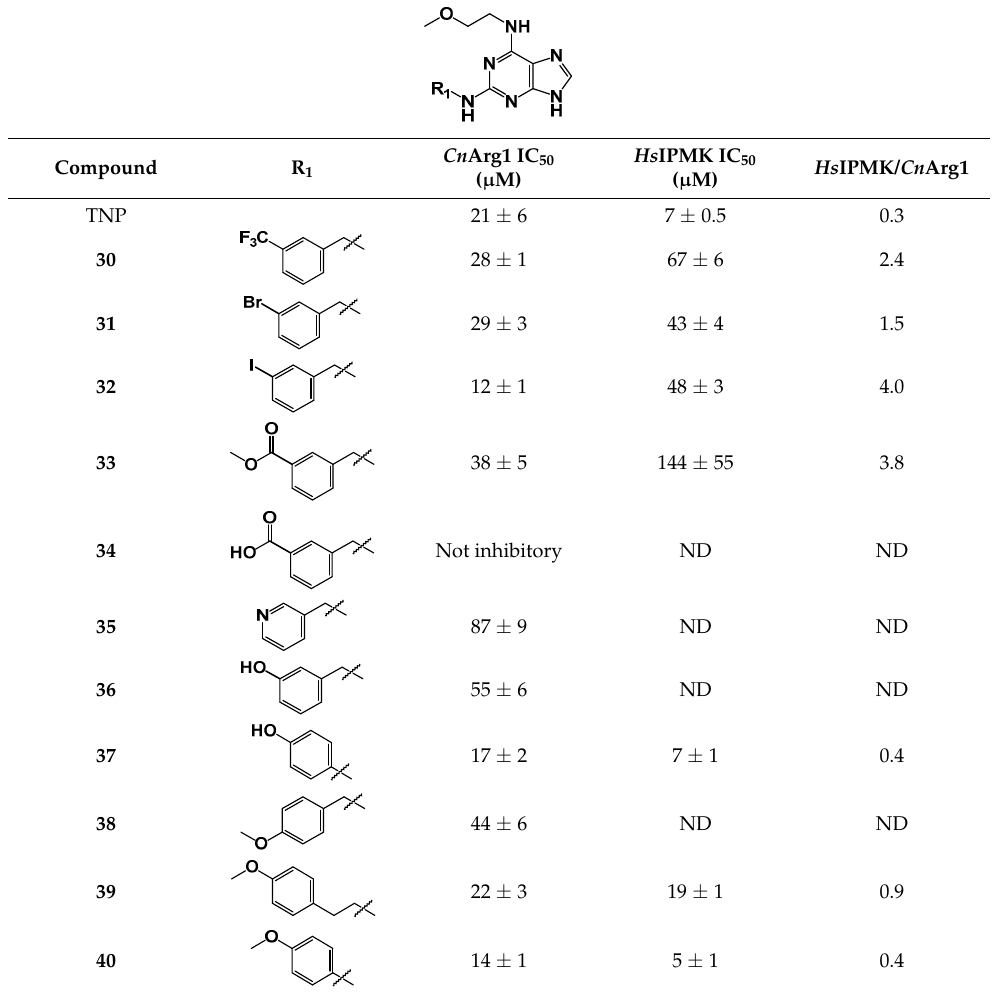
Table 4. Summary of inhibitory properties resulting from chemical exploration at the N 2 position of N 6-methoxyethyl purine (11 analogues). Only potent and soluble analogues with an IC 50 < 40 µM for Cn Arg1 were tested for inhibitory properties against Hs IPMK. ND = not determined.